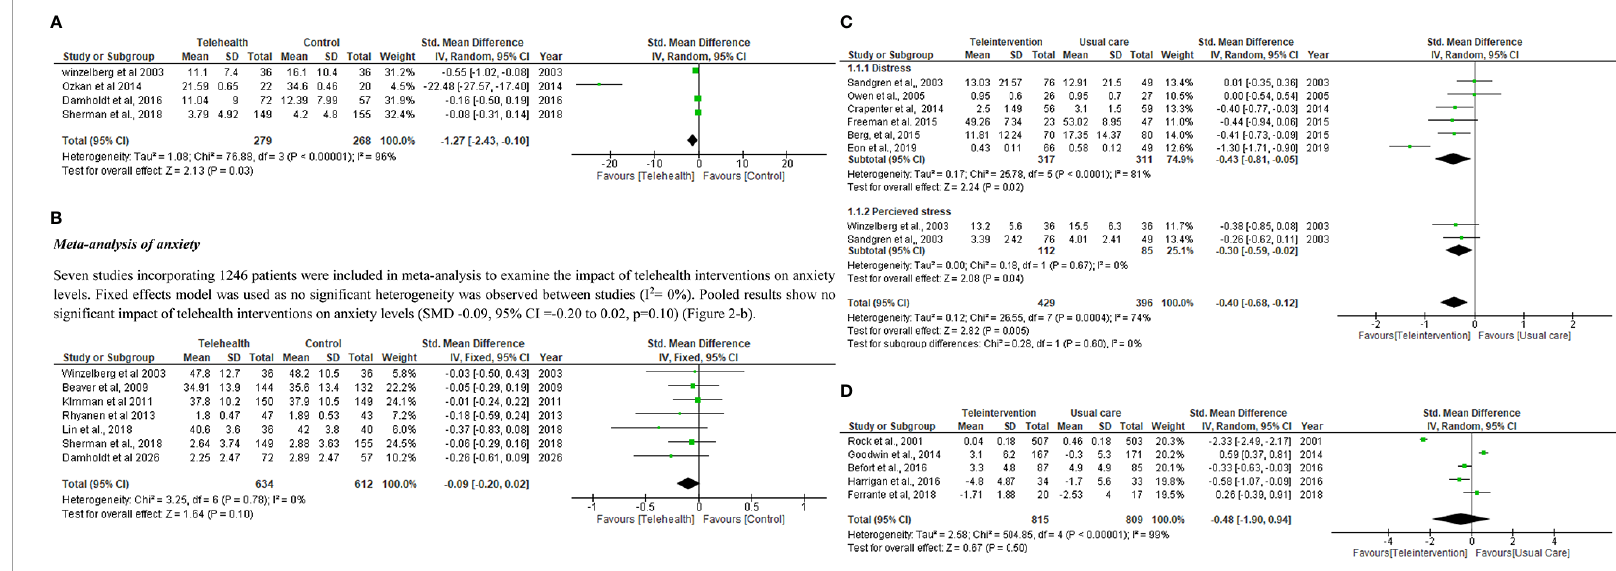
FIGURE 2 (A) Meta-analysis of depression. (B) Meta-analysis of anxiety. (C) Meta-analysis of (A) Distress (B) perceived stress. (D) Meta-analysis of weight change. (E) Meta-analysis of Quality of